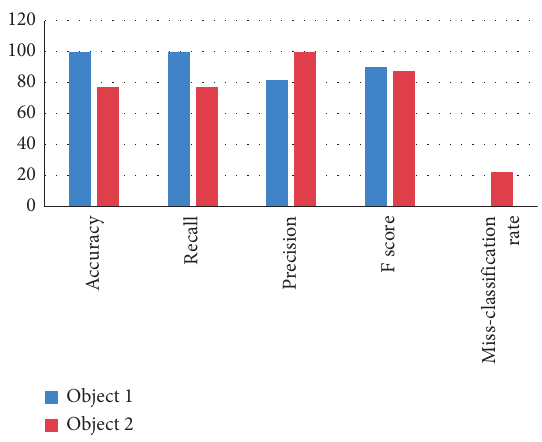
Figure 17: KNN based classification results.